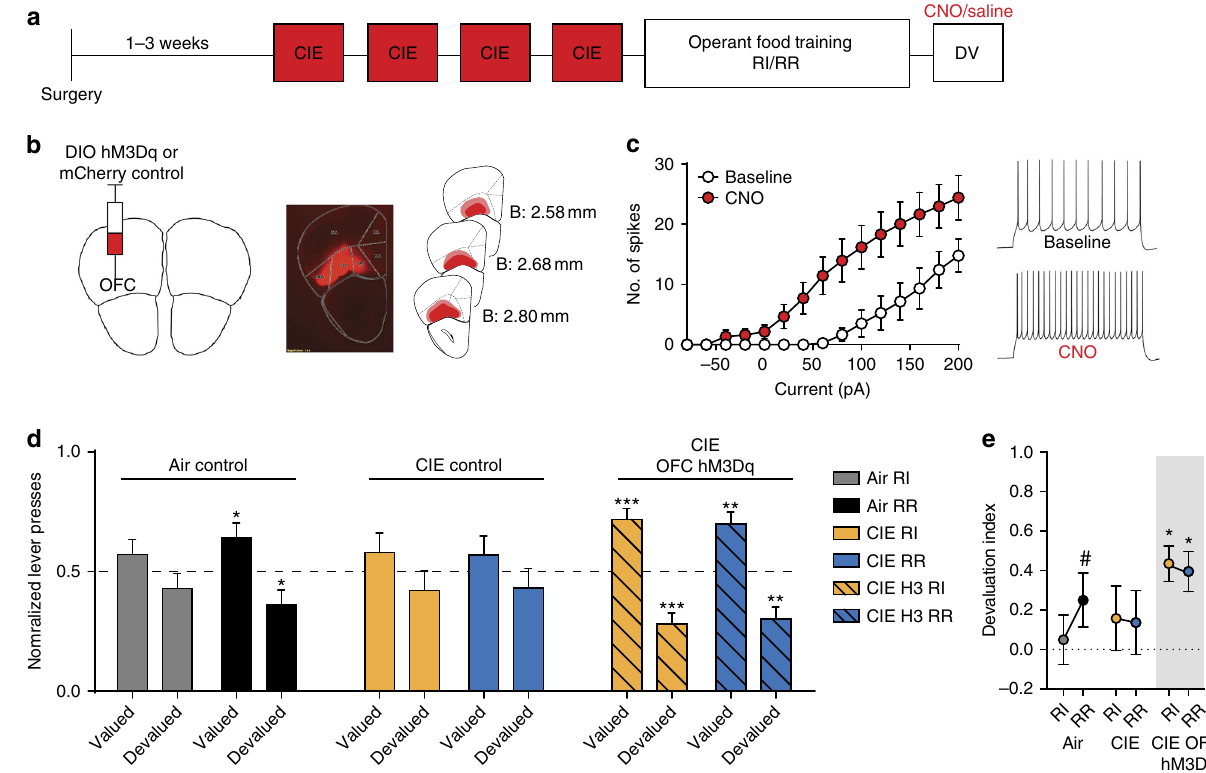
Fig. 4 Activation of OFC neurons restores control by goal-directed processes. a Experimental outline. Mice were injected with an activating DREADD (hM3Dq) in the OFC. After recovery, mice underwent CIE procedures followed by operant training and outcome devaluation testing. CNO was administered to hM3Dq expressing CIE-exposed mice (CIE H3), control CIE-exposed mice (CIE), and Air-exposed mice (Air) 30 min prior to prefeeding on both valued and devalued testing days. b Schematic of OFC injection site with hM3D-mCherry (left) and subsequent expression of mCherry in the OFC (middle). Schematic of maximum (pink) and minimum (red) boundaries of viral spread in the OFC (right). c The number of spikes plotted against the current injected (left). Representative traces of action potential fi ring at 200 pA (right) ( n = 6 cells). d Normalized lever presses for each group (three cohorts, Air n = 16, CIE control n = 14, CIE H3 n = 19) showing the distribution of lever presses between valued and devalued days in random interval (RI) and random ratio (RR) trained contexts. e Devaluation index for each group in the previously trained RI and RR contexts. Data are represented as mean ± SEM. ** p < 0.01 and *** p < 0.001 re fl ect one-sample t tests against 0.5 and * p < 0.05 and # p = 0.09 re fl ect one-sample t tests against